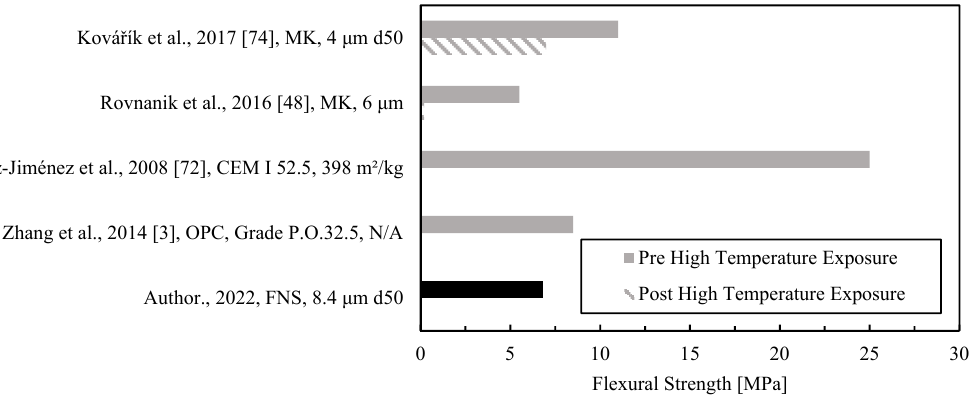
Figure 8. Compressive strength of low-calcium AAM pastes after exposure to a thermal load be- tween 800 and 1000 °C.